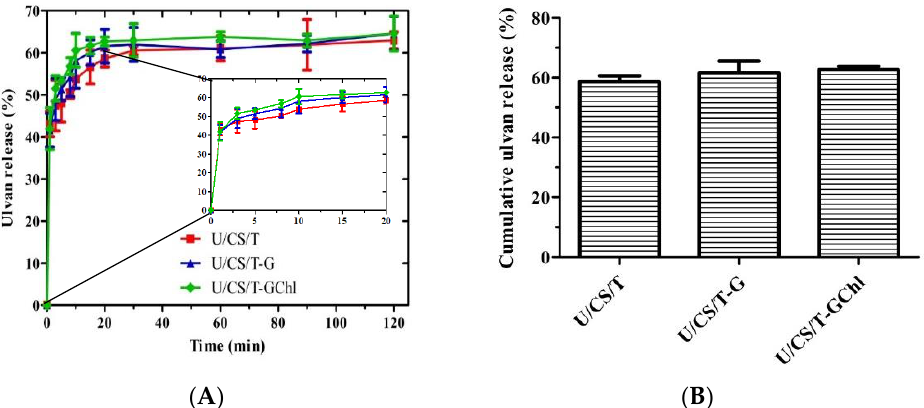
Figure 2. ( A ) Ulvan release percentage from various ulvan/chitosan complex films in distilled water; ( B ) Comparison of the ulvan release percentage at 20 min from various ulvan/chitosan complex films in distilled water. All the complex films had the same composition of U/CS/T at 20/75/5. Data were represented by the mean ± SD, n = 3.